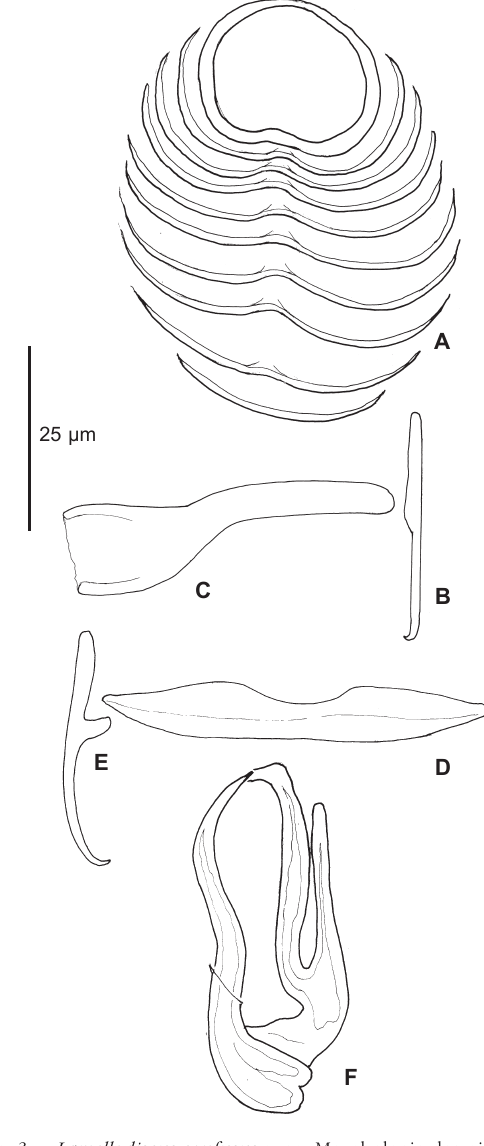
Fig. 3. – Lamellodiscus confusus n. sp. Morphologie des pièces sclé- rifiées. Abréviations - A : lamellodisque; B : anchor dorsal; C : barre latérale dorsale; D : barre médiane ventrale ; E : anchor ventral; F : appareil copulateur mâle. Échelle : 25